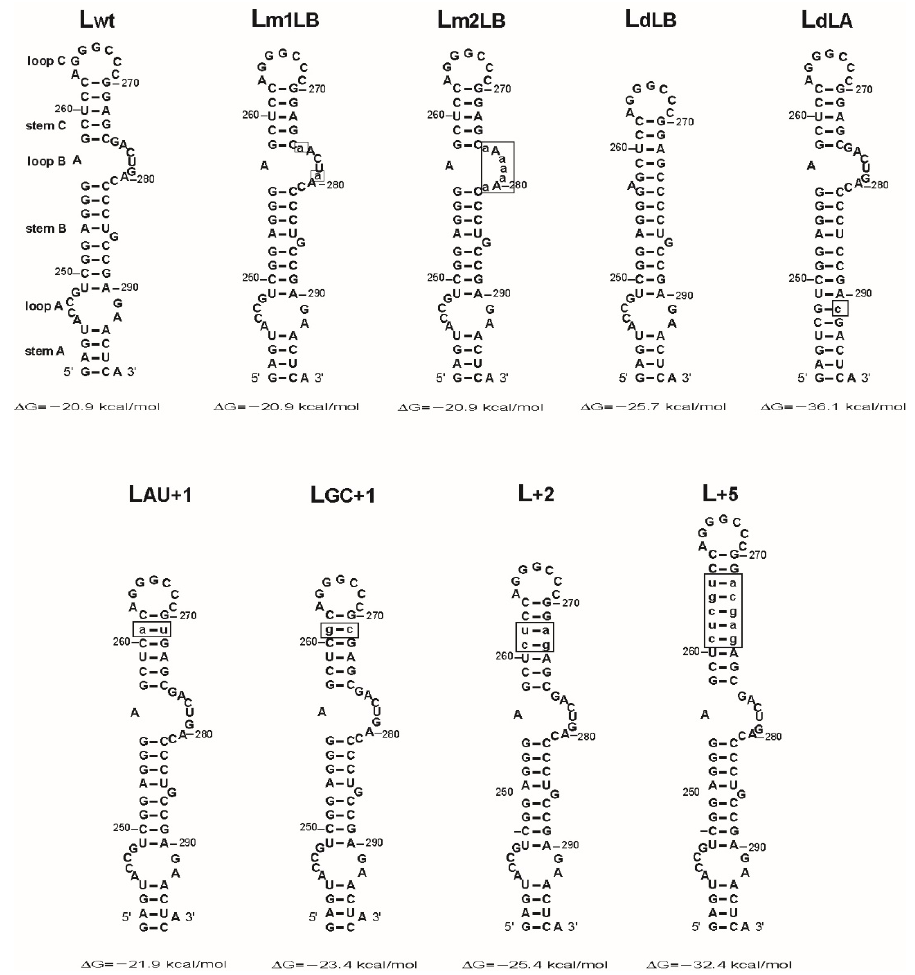
Figure 3 . Predicted secondary structures for the L3 sequence of LRNAs containing mutations or deletions. The mfold program [40] predicted the most stable secondary structure for each RNA. Numbering is relative to the genomic RNA cap site (+1). The lower-case letters in the boxes indicate the mutations.